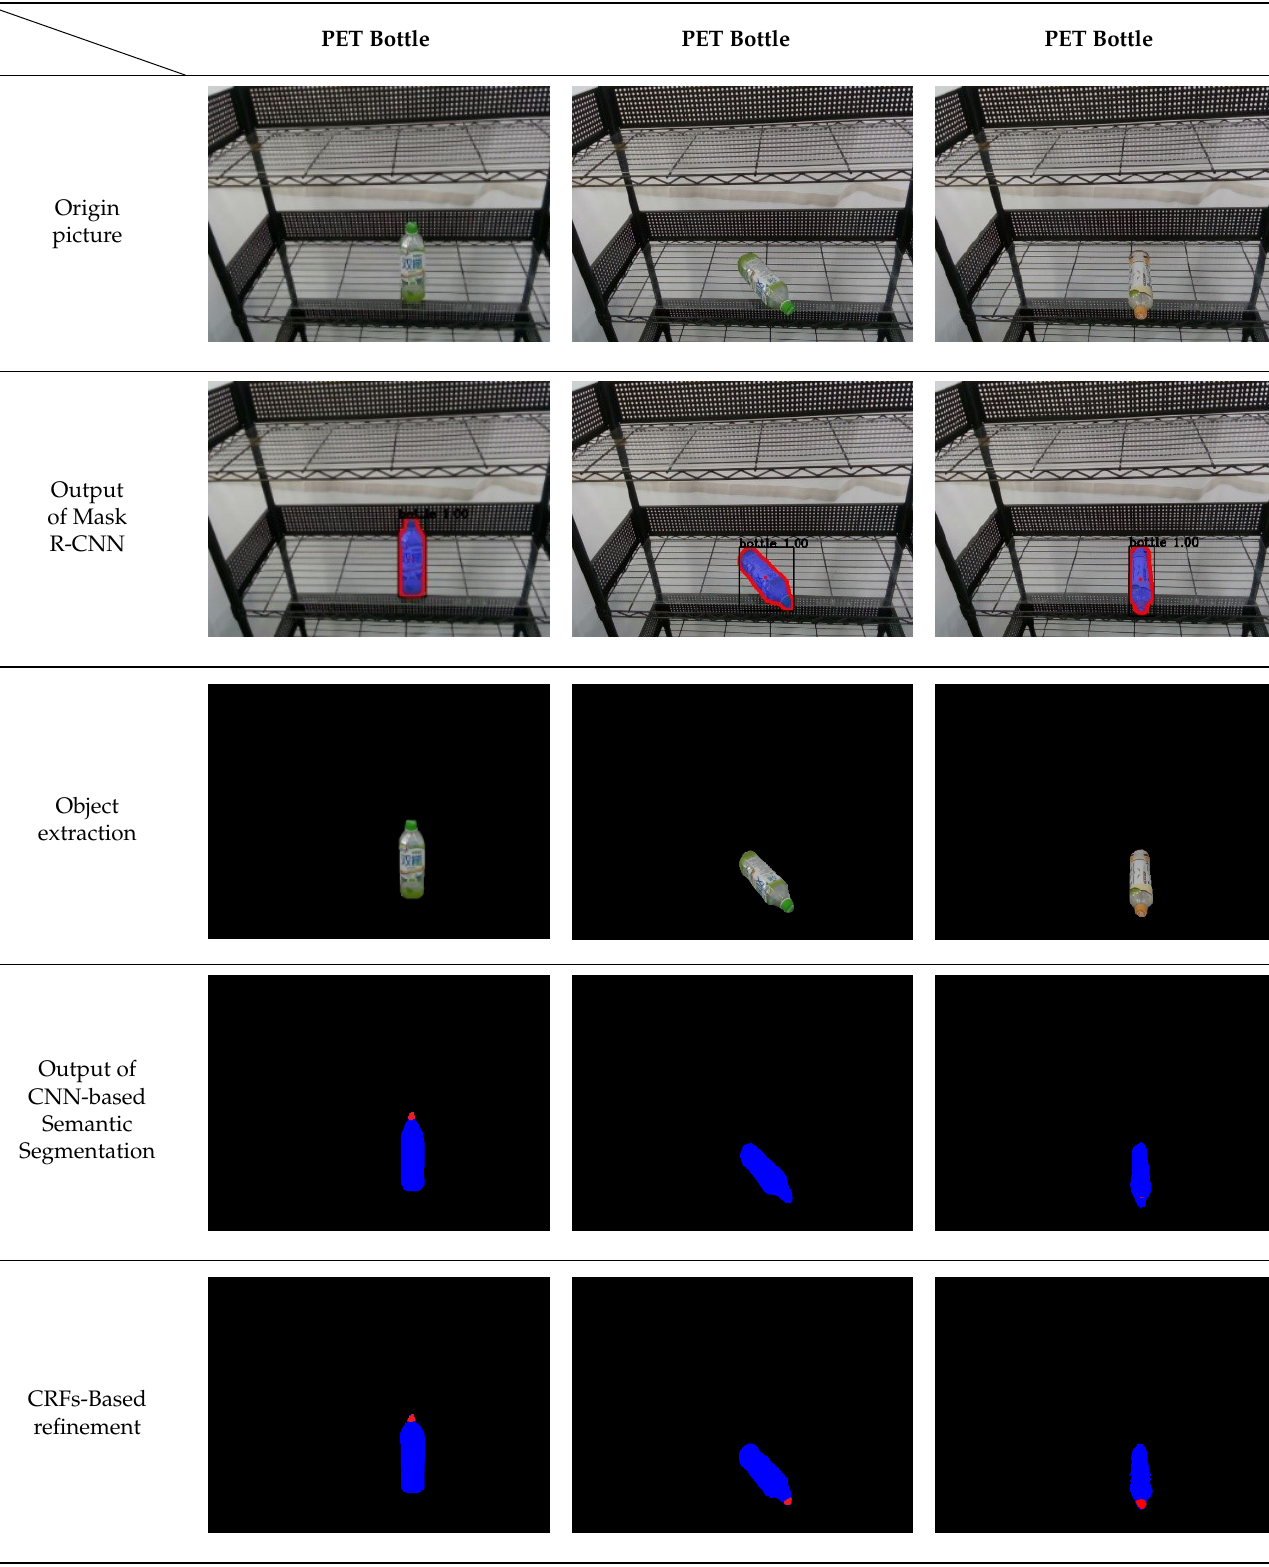
Table 3. Image processing results of three different pose of the PET bottle obtained by the proposed CNN-based object detection